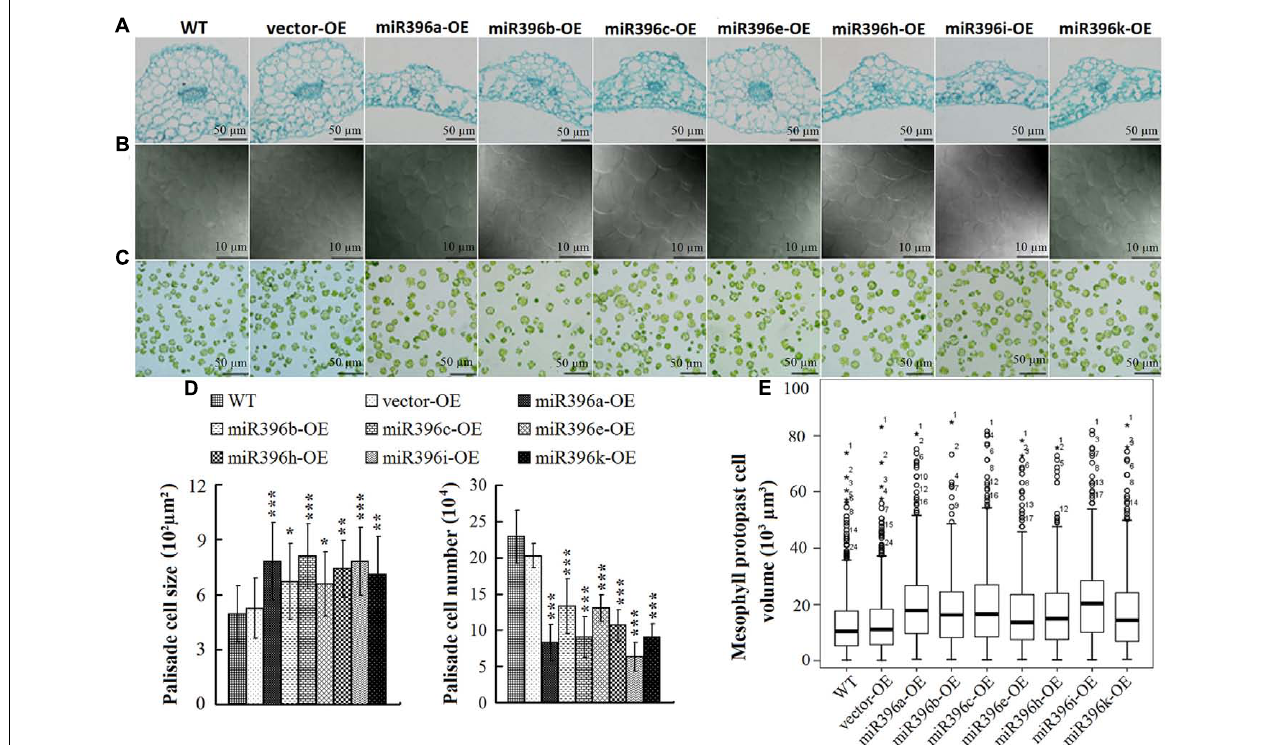
FIGURE 5 | Cell proliferation and expansion in miR396a/b/c/e/h/i/k-OE transgenic Arabidopsis leaves. (A) Histological sections cut at half-way down main vein. (Bar = 50 µ m). (B) View of palisade cells at central region between mid-vein and leaf margin (Bar = 10 µ m). (C) View of mesophyll protoplast. (Bar = 50 µ m). (D) Palisade cell size and palisade cell number per unit area. Data are average of 30 views ± SD, asterisks indicate significant difference applying ANOVA ( ∗ P < 0.05; ∗∗ P < 0.01; ∗∗∗ P < 0.001). (E) Box-plot chart analysis of mesophyll protoplast cell size (300 cells): box indicates 25 and 75% percentiles, line across the box depicts the median, whiskers represent maximum and minimum values, plus sign represents maximum, or minimum outlier.